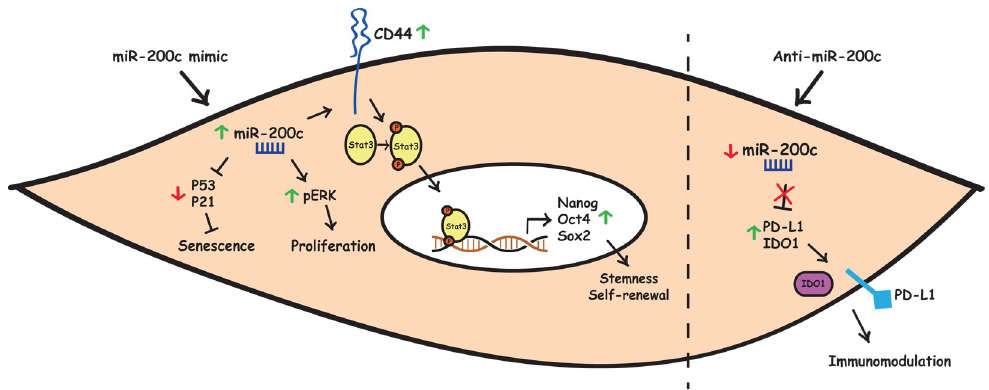
Fig 6. Graphical summary of how miR-200c-3p may regulate self-renewal, proliferation, senescence and have immunomodulatory effect in ASCs. Left: in the cytoplasm, over-expression of miR-200c-3p (green arrow) may stimulate cell proliferation through an increase of p-ERK and inhibit cell senescence by downregulating p53/p21 axis (red arrow). MiR-200c-3p can also increase CD44 expression leading to STAT3 phosphorylation, which in turn may activate transcription of stemness-related genes in the nucleus. Right: Inhibition of miR-200c-3p with a specific anti-miR (red arrow) alleviates repression of PD-L1 and IDO-1, the inhibitory checkpoints, to regulate immune responses against ASCs.